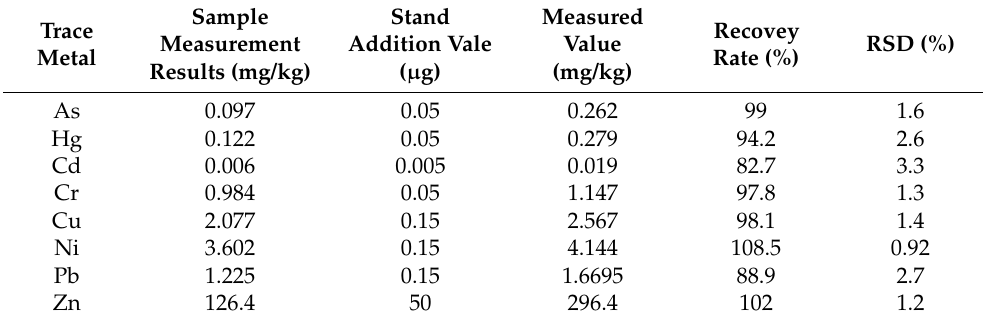
Table A5. Label recovery results (fish).